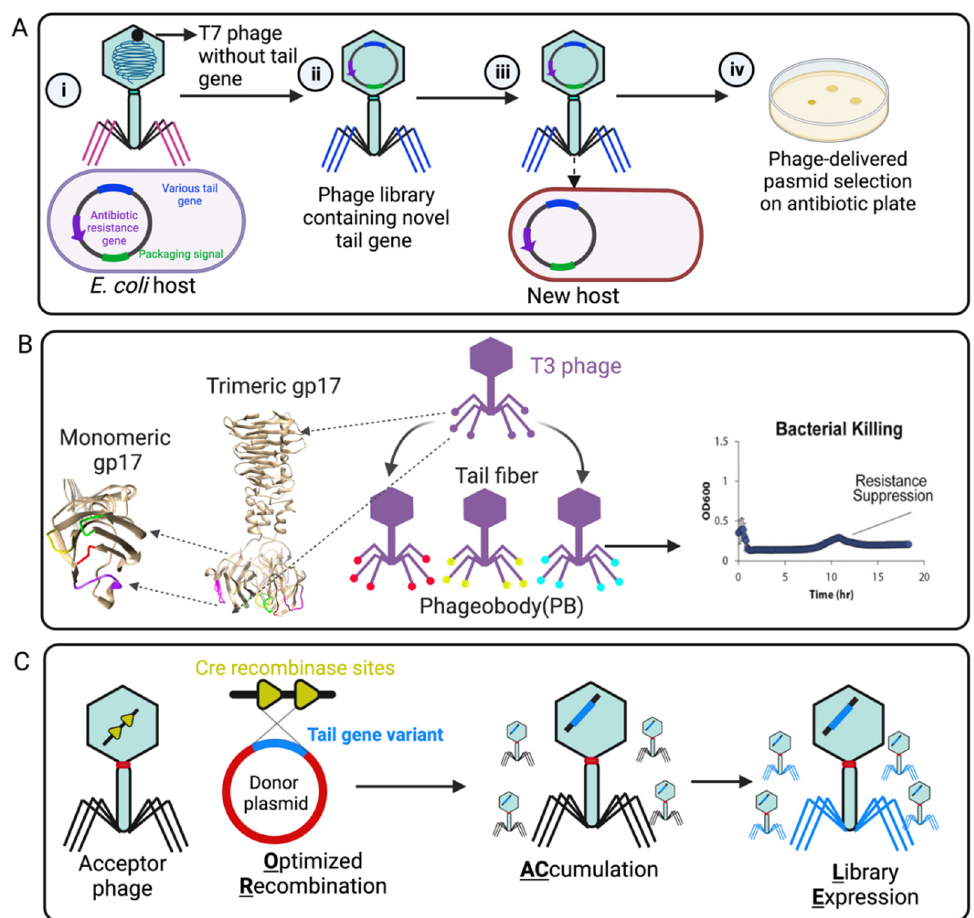
Figure 4. Representative engineering strategies of phage tail fiber. ( A ) GoTrap model [100]: (i) T7 phage without a tail fiber gene infects E. coli carrying a plasmid with antibiotic resistance marker, a T7 packaging signal, and various tail components. (ii) The new phage contains a different tail fiber (iii) that can recognize a new host for plasmid transduction. (iv) A new host containing the phage-transduced plasmid is selected on an antibiotic plate. ( B ) Phagebody model: The loop region (tip) of T3 phage gp17 for random mutagenesis is marked by magenta, green, yellow, and red. The selected phageobody can suppress bacterial growth [101]. ( C ) ORACLE method: An acceptor phage is generated in which the tail fiber gene is replaced with a fixed sequence flanked by CRE recombinase sites (a landing site for inserting tail variants) (yellow). The phage variants are then generated within the host by Cre-mediated optimized recombination by inserting tail fiber variants from a donor plasmid (blue, containing single amino acid substitution) into the landing sites [102]. Created by BioRender.com.